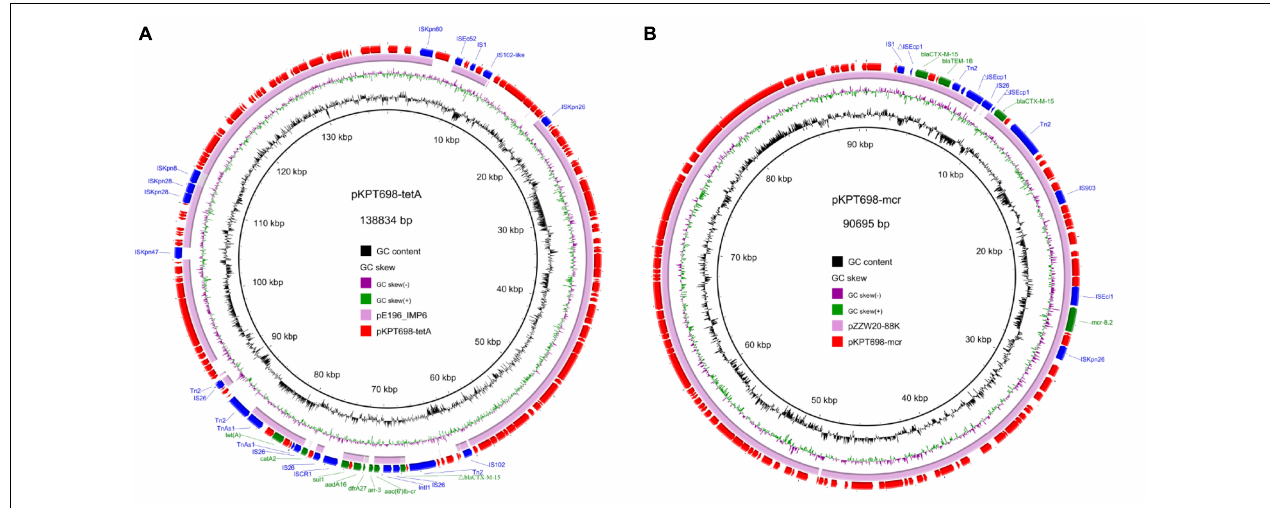
FIGURE 2 | Circular plasmid maps of pKPT698-tetA (A) and pKPT698-mcr (B) . Green, blue, and red arrows indicate the antimicrobial resistance genes, mobile elements, and other predicted ORFs, respectively. The names of antimicrobial resistance genes, mobile elements are labeled alongside the corresponding arrows. (A) The MDR region of pKPT698-tetA including aac(6 (cid:48) )Ib-cr , arr-3 , dfrA27 , aadA16 , sul1 , and catA2 was bordered by the transposable element Tn 2 . (B) pKPT698-mcr carried bla CTX − M − 15 (two copies), bla TEM − 1 B , mcr-8.2 with mobile elements such as IS 903B and IS Ecl1 inserting into this